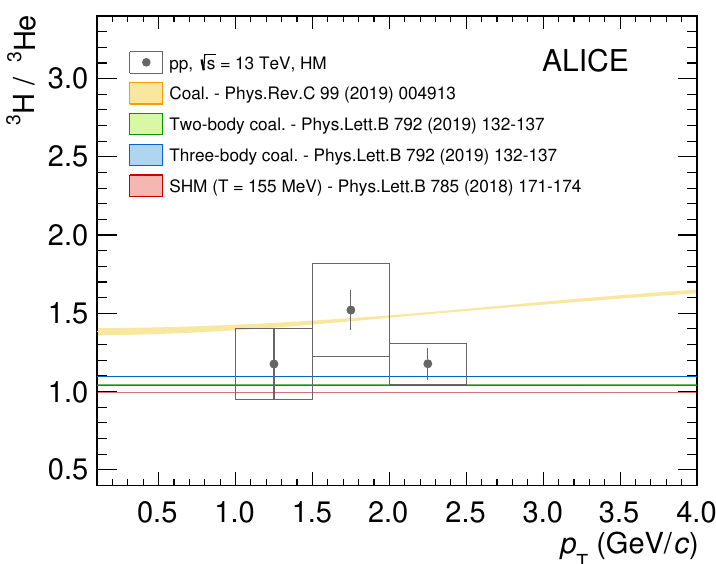
Figure 4. Ratio between the p T spectra of triton and helion for the HM data sample. Vertical bars and boxes represent statistical and systematic uncertainties, respectively. The measurements are compared with the prediction of thermal (red) and coalescence models from ref. [36] (yellow) and ref. [33] (green and